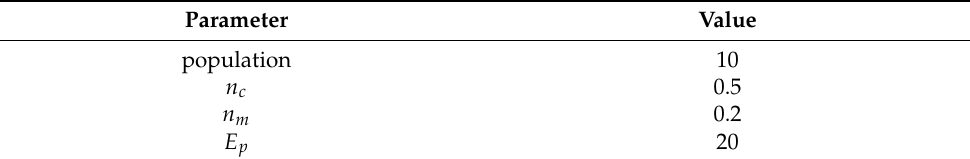
Table 1. Genetic algorithm parameter